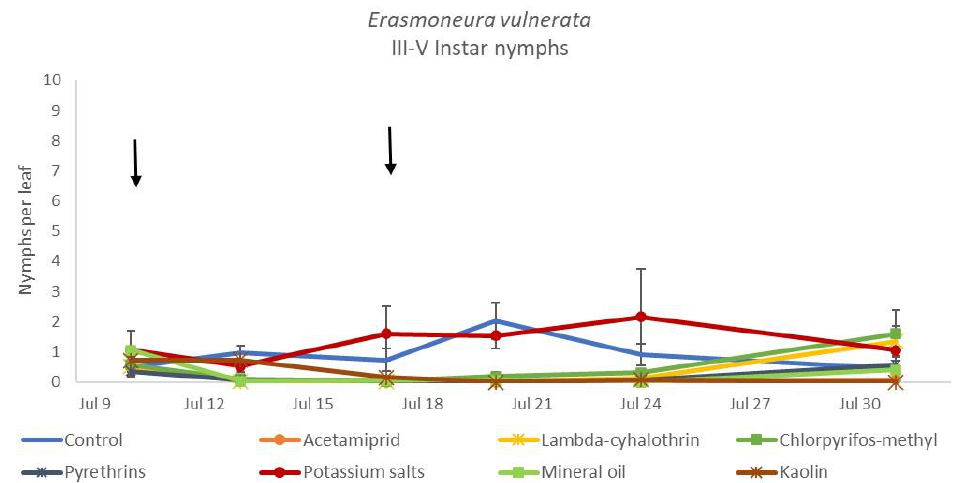
Figure 10. Dynamics of Erasmoneura vulnerata older (III-V instar) nymphs (mean ± std. err.) in the 2018 trial. Insecticides were applied one (first arrow) or two times (second arrow, see Materials and Methods section) .